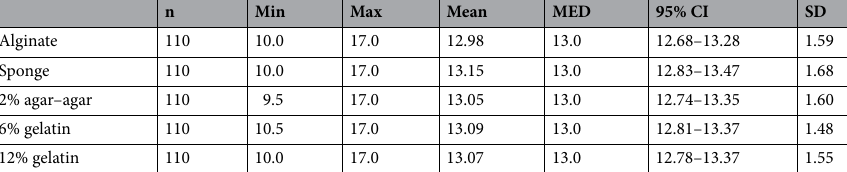
Table 2. Statistical evaluation of the working length determination with the Elements Diagnostic Unit apex locator and five different embedding media (mm; MED = median, 95% CI = 95% confidence interval of the difference; SD = standard deviation; n = 110 per research